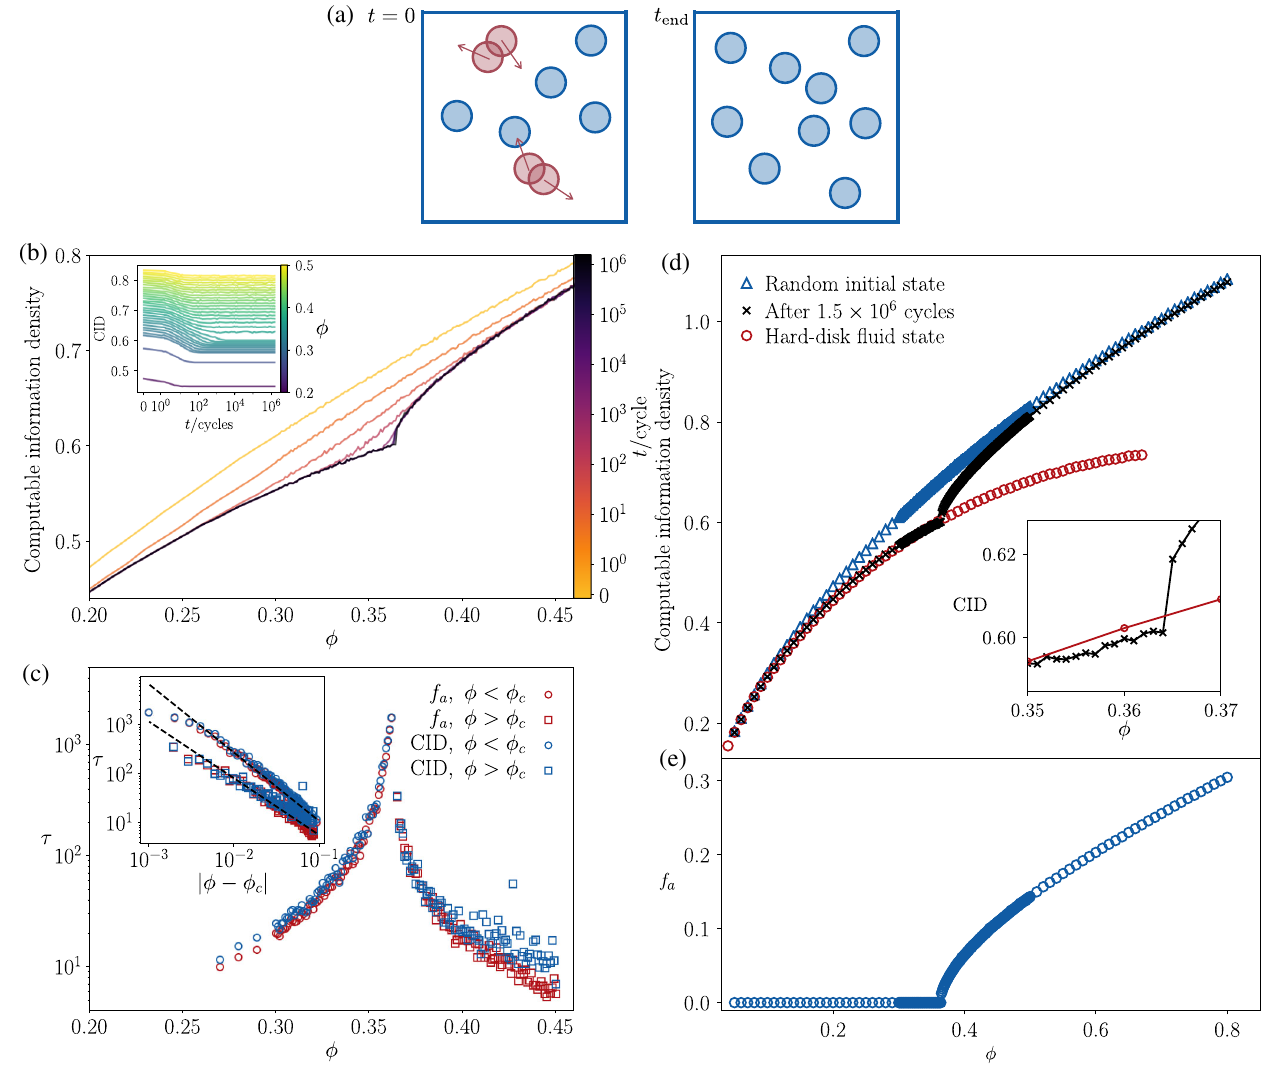
FIG. 4. 2D random organization model with 26 569 × ϕ disks of diameter d . Coordinates are quantized (digitized) using a square grid ffiffiffi p 3 with bin size approximately d= . (a) At time t ¼ 0 the system is in a randomly sampled ideal gas configuration and disks are considered active when overlapping (active disks in red). Over each cycle the active disks are given a random displacement of size ϵ ¼ d= 3 , possible moves are illustrated by the red arrows. When the area fraction is below ϕ , the system relaxes to an absorbing state, c 0 . (b) CID as a function of area fraction ϕ for different times, a cycle corresponds to N such that the fraction of active particles f a ¼ attempted parallel moves (one per particle). The system orders as a function of time, developing a cusp at the critical area fraction ϕ ≈ 0 . 364 . the inset shows the CID time-evolution profile for several densities. (c) Characteristic time τ as a function of density ρ , as c measured by the decay of f and CID, exhibiting a divergence near ρ , in line with the cusp minimum in panel (b). The inset shows τ as a a c function of j ρ − ρ , exhibiting identical power-law divergence and critical exponent ν ¼ 1 . 2 (cid:2) 0 . 2 for both measures. Lines of best fit c j k (dashed black lines) were obtained by bootstrapped minimum mean-square error fits using a robust covariance estimator [38,39]. (d) Comparison of the random initial states, states found by the dynamics after 1 . 5 × 10 6 cycles and hard-disk fluid state corresponding to uniformly sampled absorbing states; the inset shows that near the critical point the absorbing states arrived at by the dynamics have lower CID, and are more ordered than the uniformly sampled ones. (e) Fraction of active sites as a function of ϕ